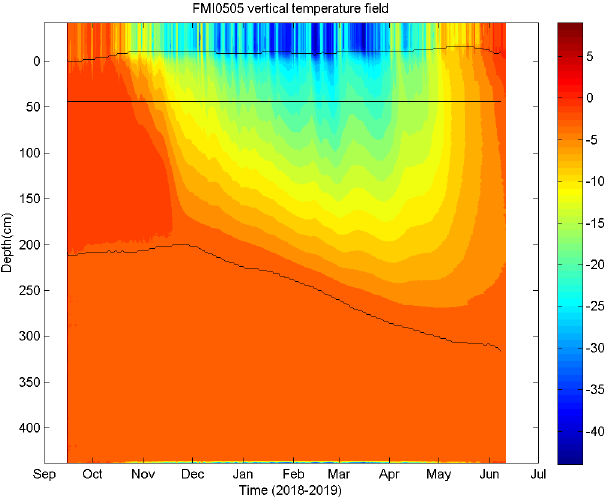
Figure 6. SIMBA observations of the temporal evolution of the snow depth, ice thickness, and temperature profile from the ocean through snow and sea ice to air. The results were obtained by ap- plying the algorithm by Liao et al. (2018). The black lines are snow surface (top), initial freeboard (middle) and ice base (bottom); 0 level refers to the snow–ice interface. The colours indicate the tem- perature in degrees